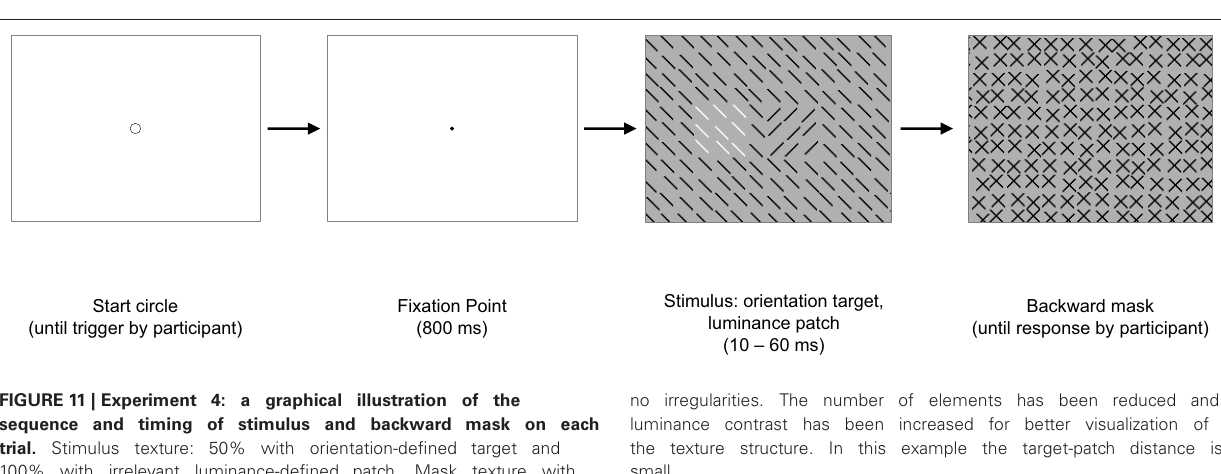
FIGURE 11 | Experiment 4: a graphical illustration of the sequence and timing of stimulus and backward mask on each trial. Stimulus texture: 50% with orientation-defined target and 100% with irrelevant luminance-defined patch. Mask texture with